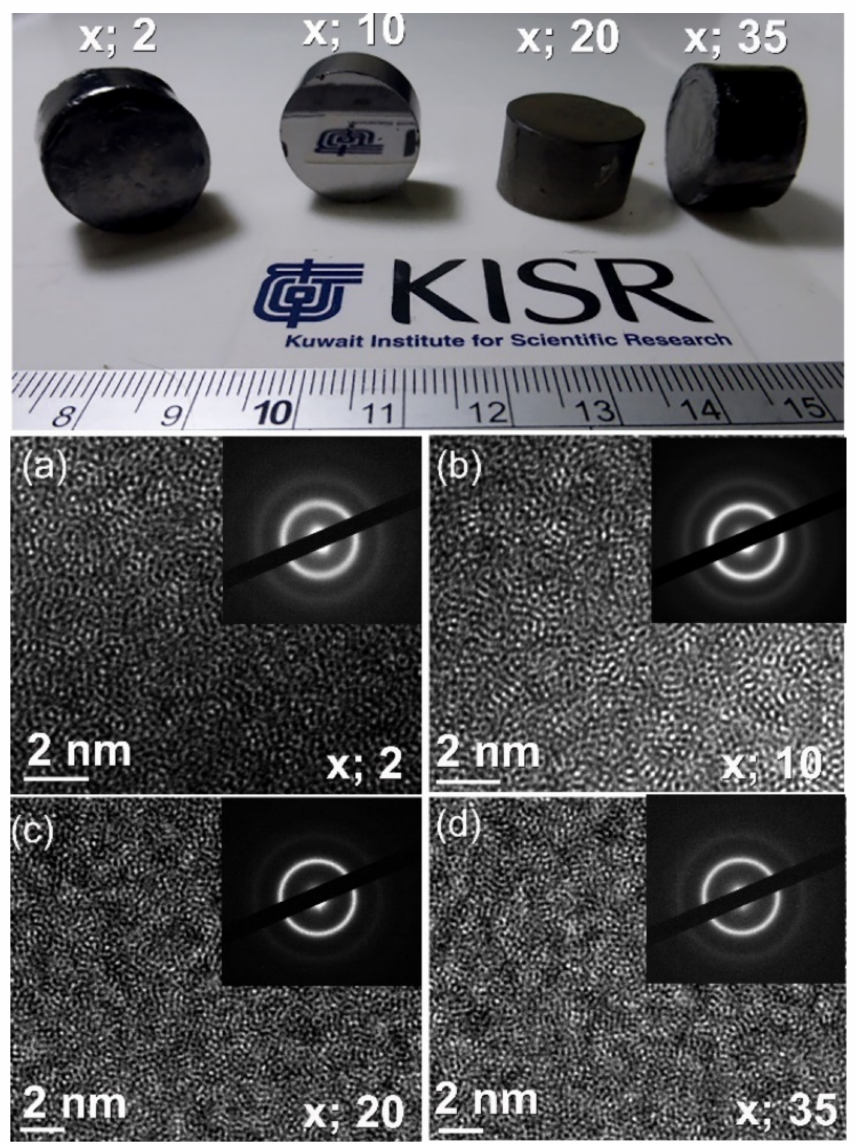
Figure 11. The upper photos display the as-SPS bulk metallic glassy buttons of (Zr 75 Ni 25 Al 5 ) 100-x W x (x; 2, 10, 20, and 35 at. %) alloy powders. The corresponding FE-HRTEM images and related NBDs for x; 2, 10, 20, and 35 at. % are displayed in ( a – d ), respectively. To verify the ability of producing an exceptionally large (Zr 70 Ni 25 Al 5 ) 65 W 35 bulk metallic glassy (BMG) alloy, the as-milled glassy powders were charged into a 50 mm graphite die with a high aspect ratio of 10:1 (Figure 10b). The system was then fed into the SPS machine, where it was heated to 920 K at a rate of 300 ◦ C/min for the consolidation process. Figure 12(ai,aii) show the as-SPS 50 mm BMG buttons before and after polishing. The polished glassy button had a smooth surface and glistened metallically (Figure 12(aii)). Furthermore, the consolidated sample exhibited a dense look devoid of fractures or